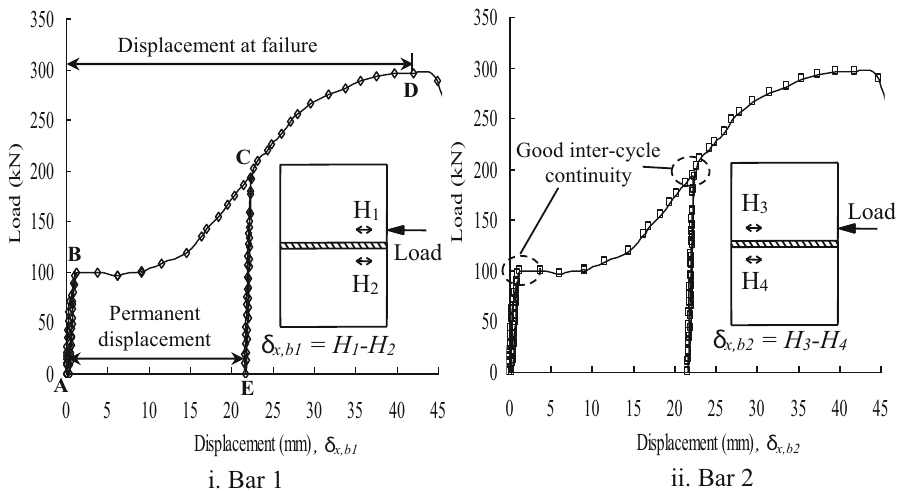
Fig. 11 Comparison of load–displacement for bars 1 and 2 (Specimen WBS).